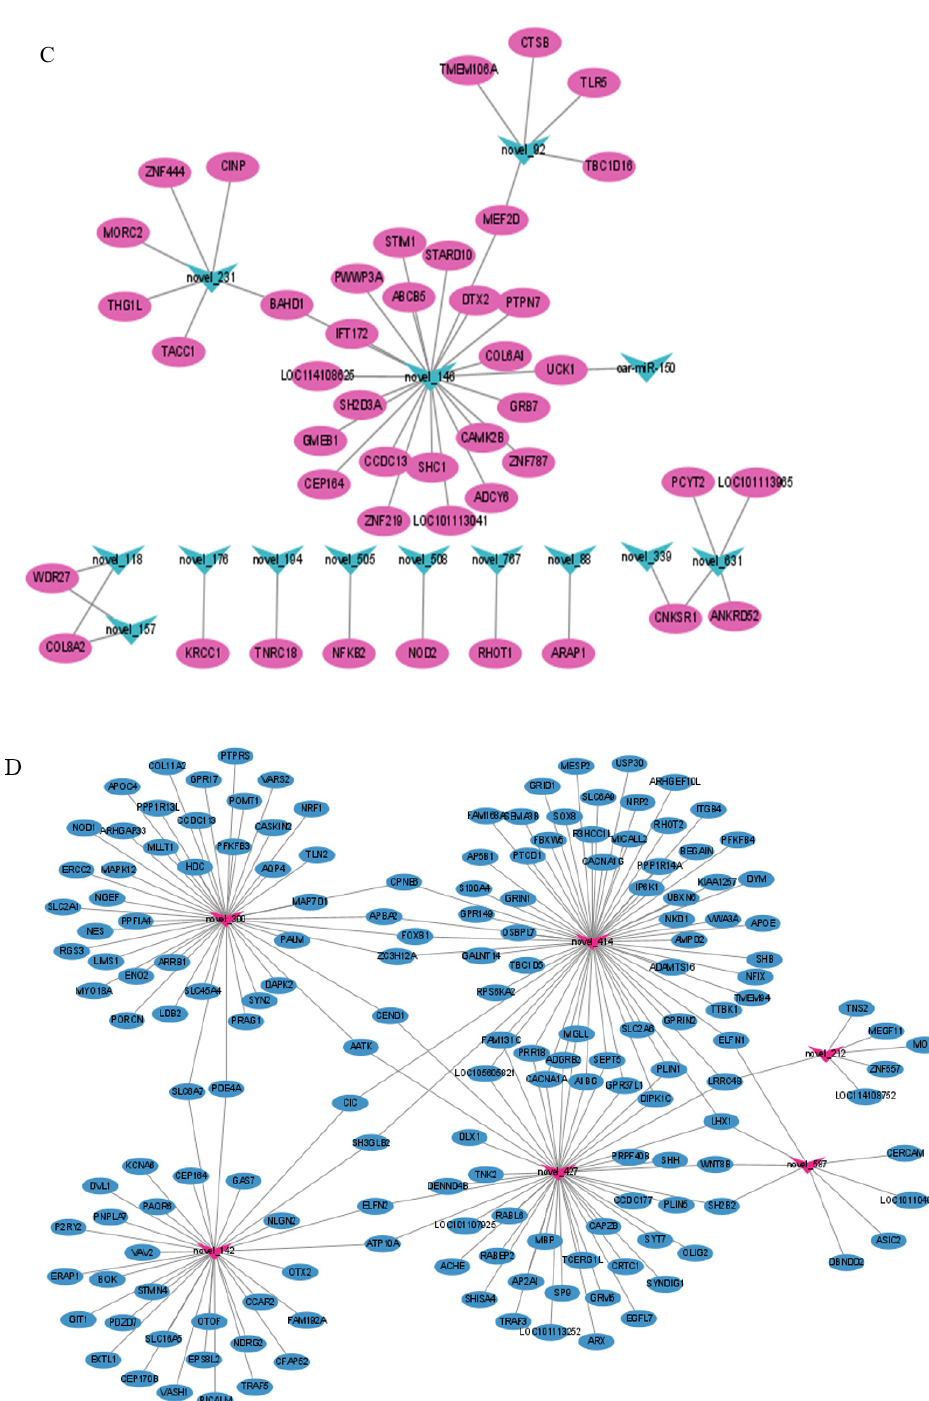
Figure 6. Regulatory networks of DE miRNA ‐ mRNA in hypothalamus and distal pituitary of sheep.